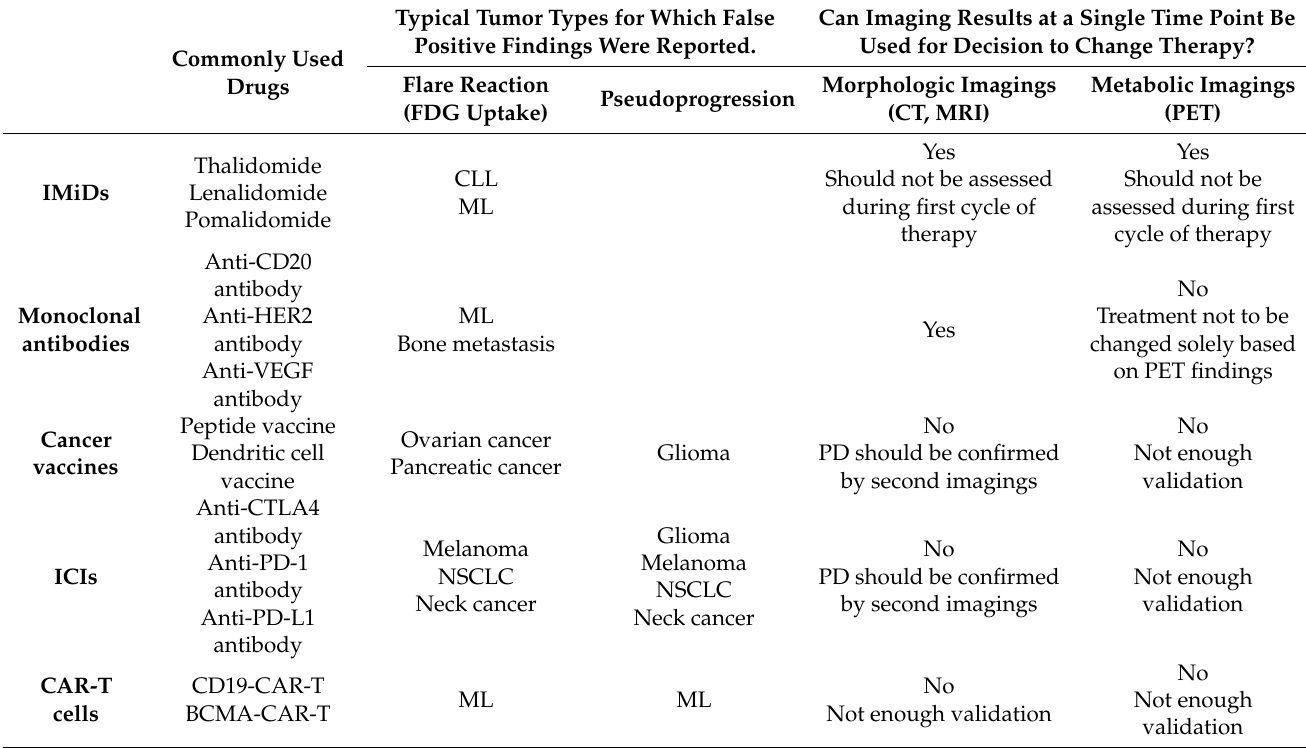
Table 1. False positive imaging and impact for response assessment for each